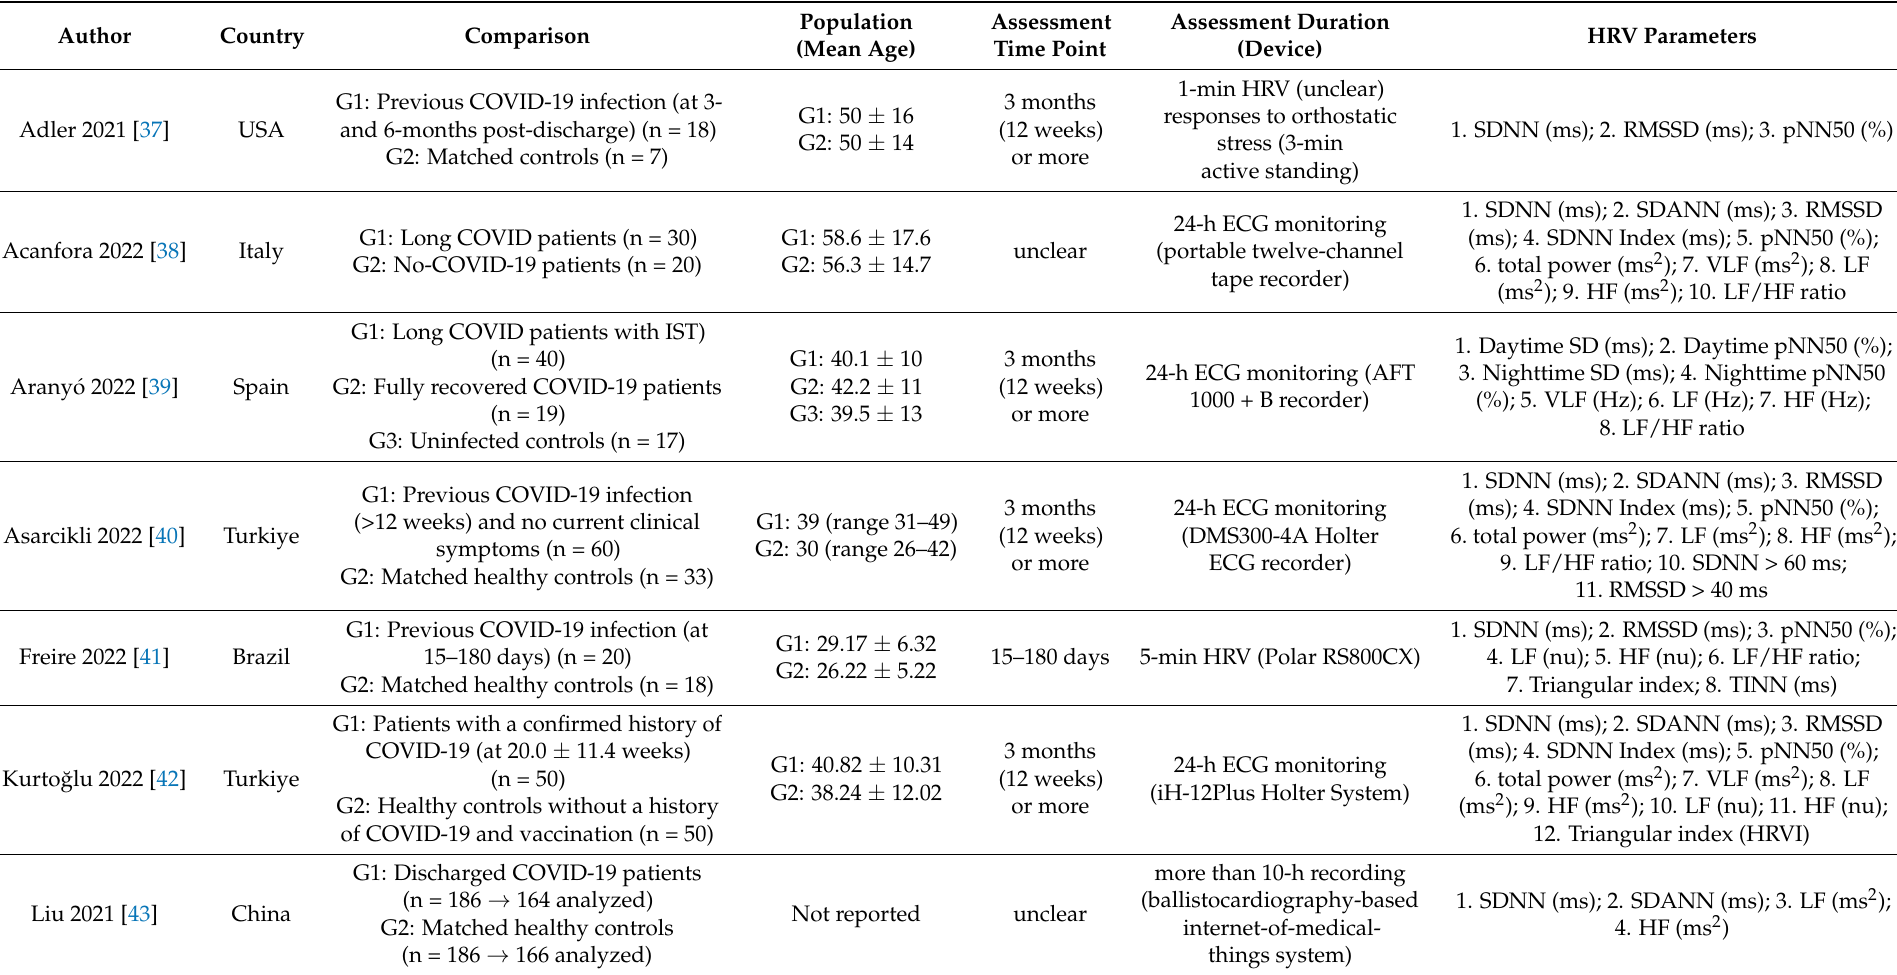
Table 1. Characteristics of the included